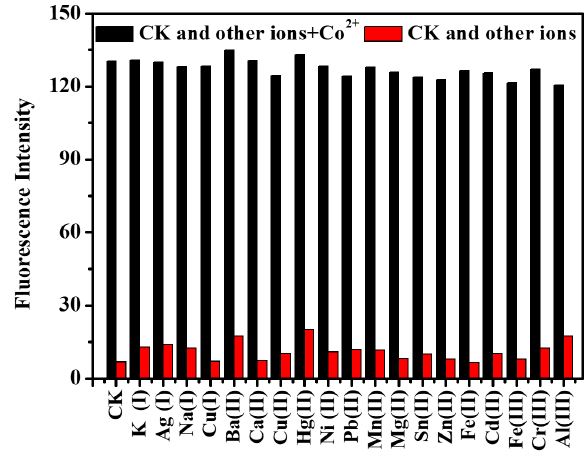
Figure 5. Fluorescence intensity at 450 nm of L (1.0 × 10 5 mol L − 1 ) upon the addition of various metal ions (15.0 × 10 5 mol L − 1 ) (red bars) and upon the addition of Co 2+ (5.0 × 10 5 mol L − 1 ) with various metal ions (15.0 × 10 5 mol L − 1 ) (black bars) in CH 3 CN/HEPES (4/1, v / v , pH = 7.4) ( λ ex = 380 nm).